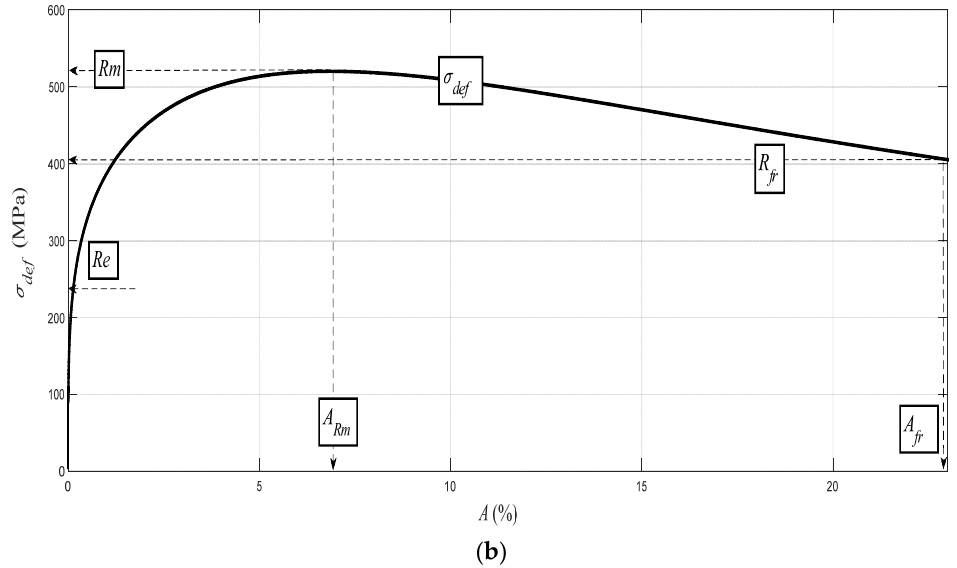
Figure 5. ( a ) Deformational diagram for the steel grade AISI 316/316L, for the dependence σ def = f ( A ) from tensile test; ( b ) Comparison diagram of the steel grade AISI 316/316L; analytical construction of dependence σ def = f ( A ).